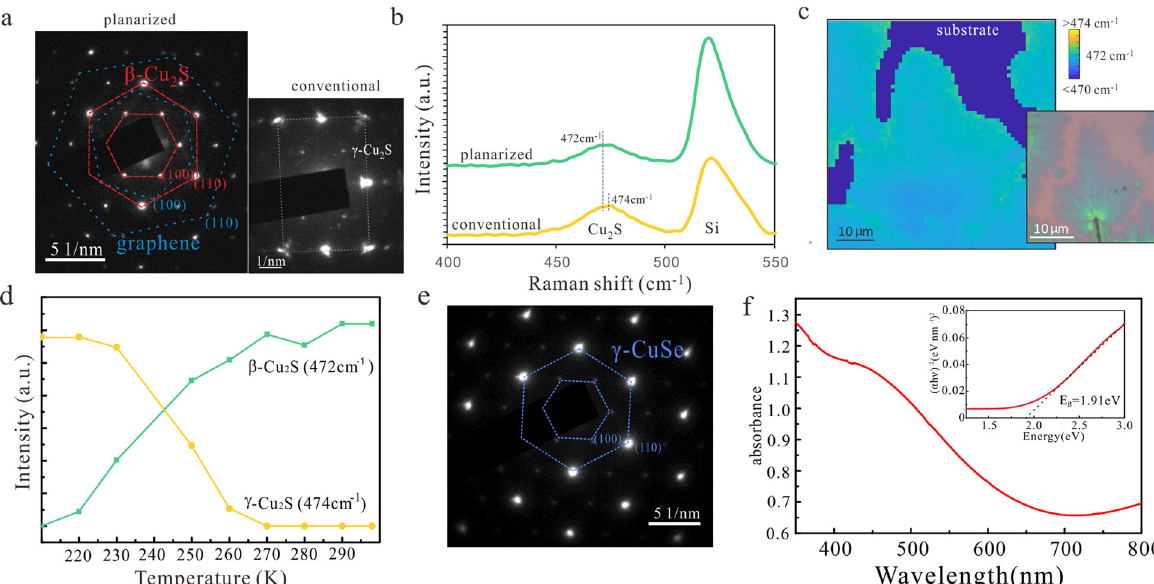
Fig. 4 Features of 2D crystals grown by planarized reaction. a Selected area diffraction (SAED) of Cu 2 S grown under planarized growth conditions and graphene-free conditions, b Raman spectra of planarized and conventionally grown Cu 2 S, c Raman A 1g peak position map (the substrate peak position was set to zero) (inset) optical micrograph of Cu 2 S on Si/90 nm SiO 2 d temperature-dependent Raman peak position indicating large phase-transition lowering, e SAED of CuSe, f absorption measurement, (inset) Tauc Plot with indication of